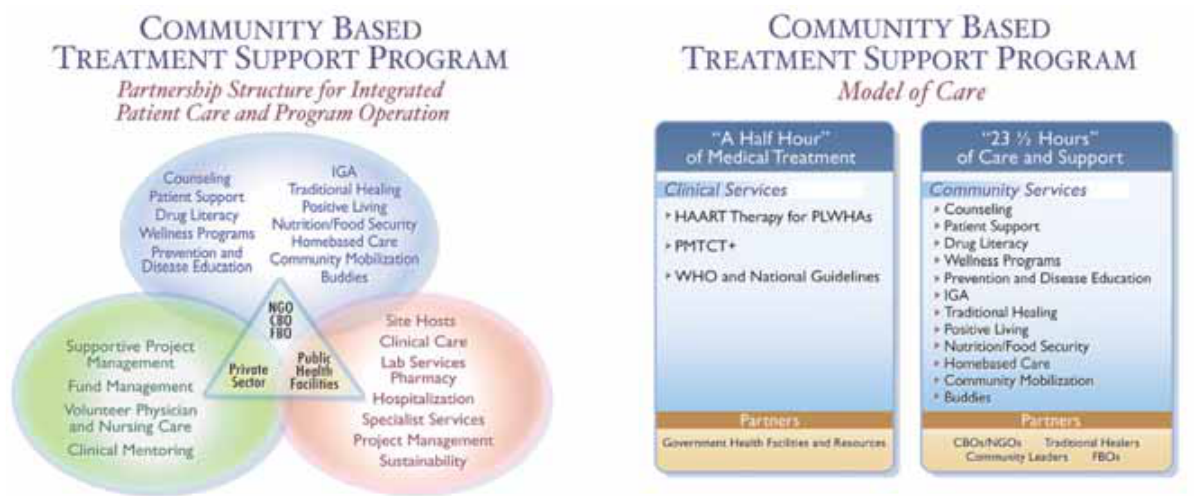
Fig. 1. Community-based treatment support model of